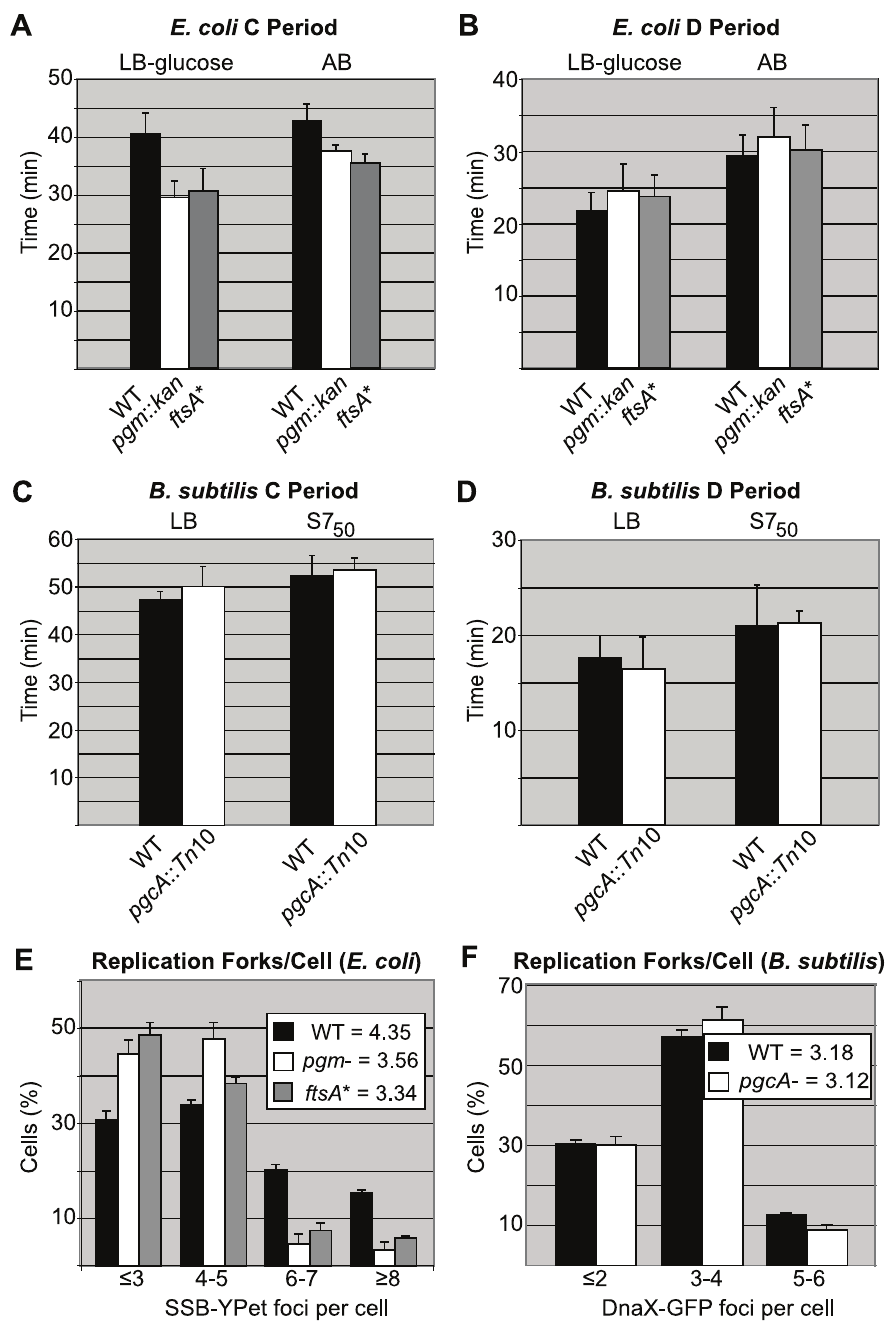
Figure 3. Replication rate is increased in short E.coli cells. (A) Average time of DNA replication (C period) is reduced by , 25% in pgm :: kan and ftsA* cells grown in LB-glucose ( left ) and by , 15% when grown in AB ( right ). (B) In contrast, C period length is wild type in B. subtilis pgcA :: Tn 10 cells in both LB ( left ) and S7 50 ( right ). The period between the end of replication and division (D period) is wild type in both the E. coli and B. subtilis mutant strains (C & D). C and D period values were calculated using marker frequency analysis of qPCR data (see Materials and Methods). Error bar corresponds to one standard deviation (n=3). (E & F) Histograms displaying the number of foci of either single-stranded DNA binding protein fused to YPet (Ssb-YPet) in E. coli (E) or a GFP fusion to Tau (DnaX-GFP) in B. subtilis (F). Note reduced number of Ssb-YPet foci in E. coli pgm :: kan and ftsA* mutants. Experiments were done in triplicate, assessing 220–260 cells per replicate. Error bars are one standard deviation. Population means are shown in the inset. The E. coli mutants had statistically fewer (p , 0.001) foci/cell by chi-square